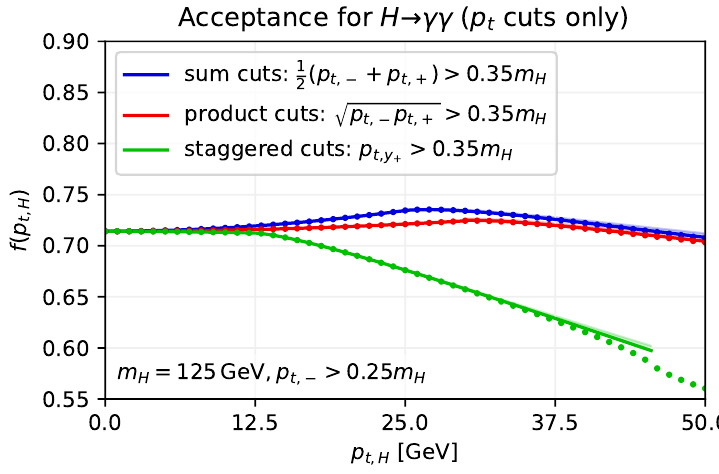
Figure 4 . Comparison of the p t, h -dependent acceptances for the sum, product and staggered cuts. For the staggered cuts, p t,y corresponds to the transverse momentum of the photon at higher + rapidity. As in figure 2, the points corresponds to Monte Carlo evaluations of the acceptances. Lines use series expansions to fourth order and bands (where visible) show the size of the fourth order term.